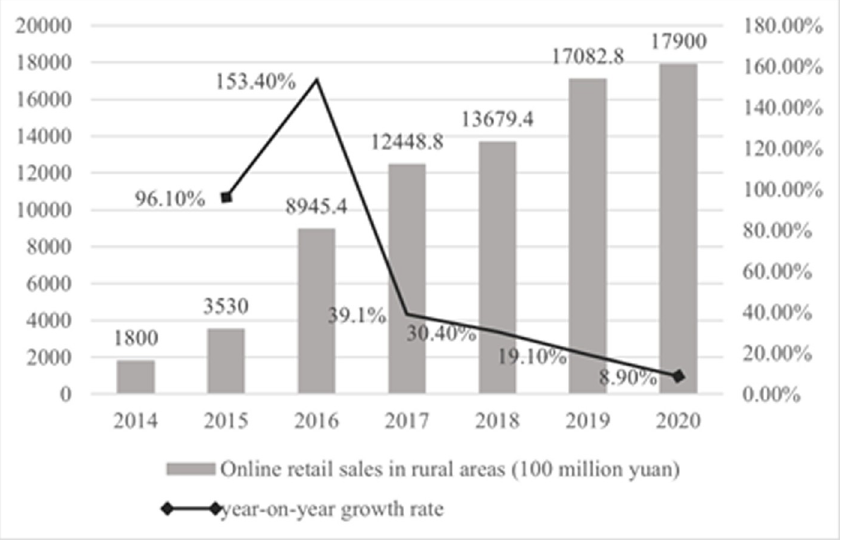
Fig 2. Rural network retail sales and year-on-year growth rate in China from 2014 to 2020. Source: Ministry of Commerce of the People’s Republic of China.